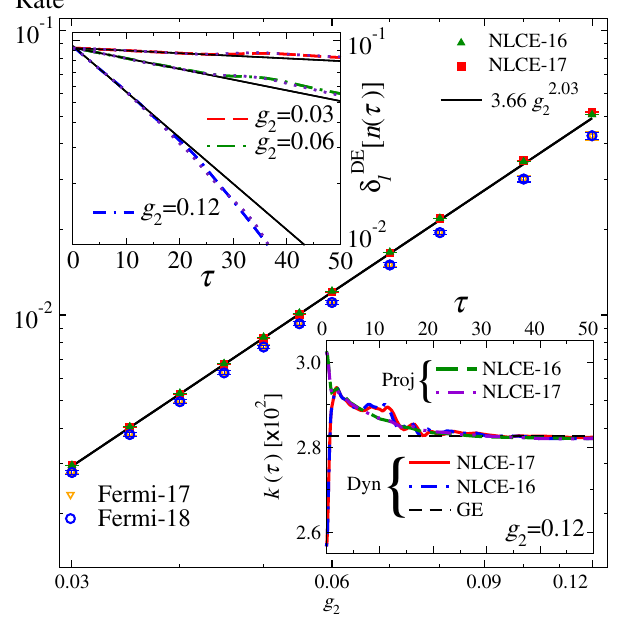
ˆ H → ˆ H FIG. 7. Dynamics after quantum quenches 2 , for t 0 I ¼ I ˆ H ˆ H V 0 and t 0 ¼ V 0 ¼ 0 in ¼ 0 in 2 (integrable reference I I dynamics). Main panel: Thermalization rates Γ NLCE ð g 2 Þ for the particle filling dynamics (filled symbols) obtained from fits as the ones shown in the upper inset. The straight line is the result of a fit to Γ NLCE 17 ð g 2 Þ ∝ g β 2 . The open symbols show the rates Γ Fermi ð g 2 Þ , see Eqs. (53) and (54), obtained using full exact diagonalization (see Appendix D). Upper inset: δ DE ½ n ð τ Þ(cid:2) , see Eq. (52), versus τ . l The straight lines depict fits to exponential functions ∝ exp ½ − Γ NLCE τ (cid:2) . The legends in the main panel and in the 17 ð g 2 Þ upper inset follow Fig. 1, and the fits are done in the same intervals as in Fig. 1. Lower inset: Dynamics, and projected ˆ H τ Þ for g 0 . 12 . The horizontal dynamics in the basis of 0 , of k ð 2 ¼ line shows the result for the grand canonical ensemble corre- sponding to the original dynamics. The legends are identical to those in Fig.